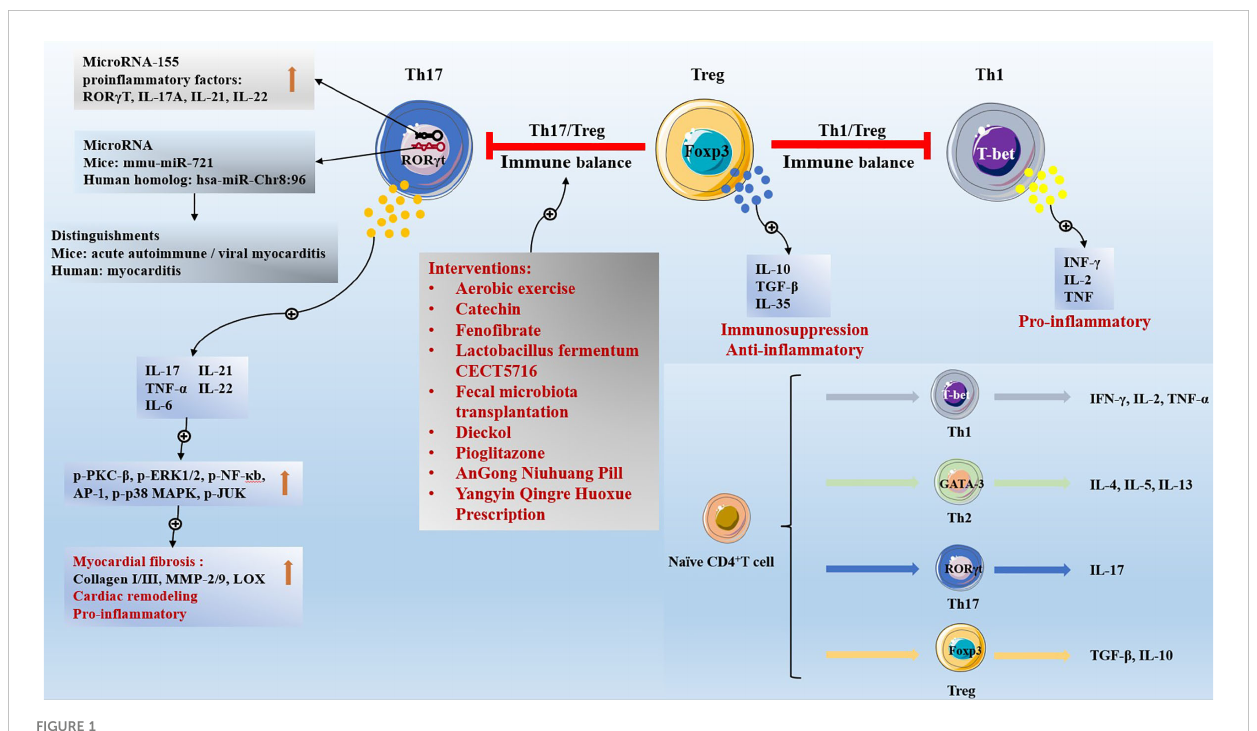
FIGURE 1 The immune balance involved by Tregs and the differentiation of Naïve CD4+ T